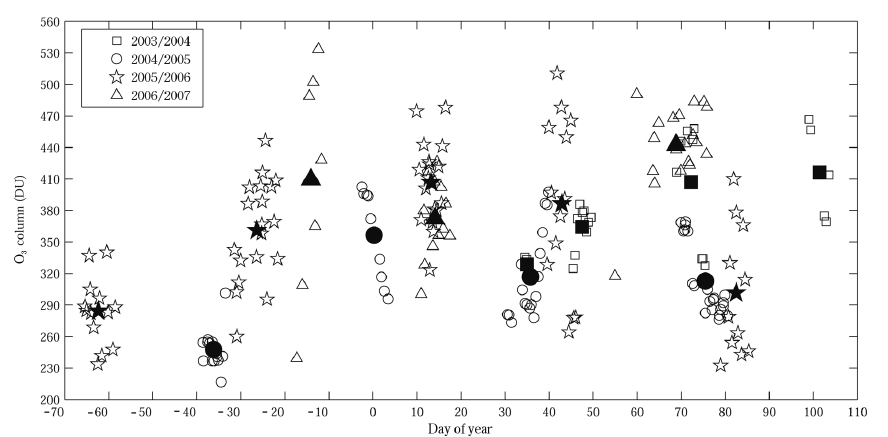
Fig. 2. GBMS O3 total column density (in Dobson Units) versus day of the year for all 4 winter periods, with 31 December at 12 GMT as day − 0.5 and 1 January as day 1. The legend shows which symbol represents each winter. Solid symbols are average values for each field campaign with first and last day of each campaign indi- cated in fig.